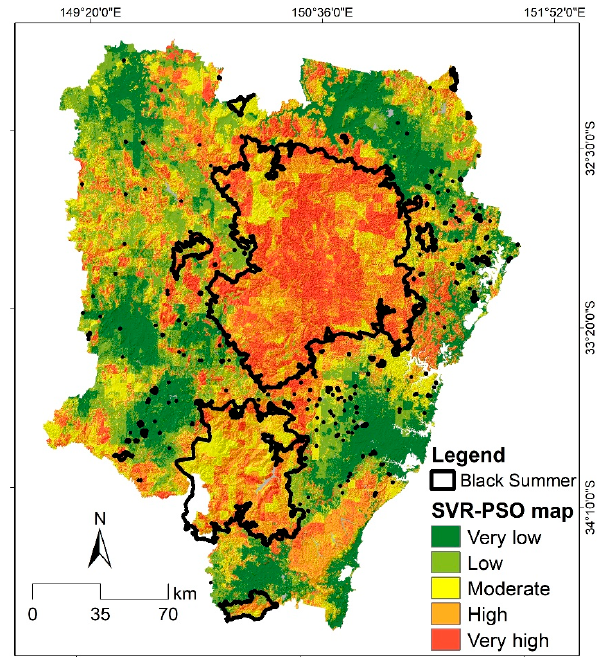
Figure 11. Comparison of the SVR-PSO map with the 2019–2020 Black Summer season.